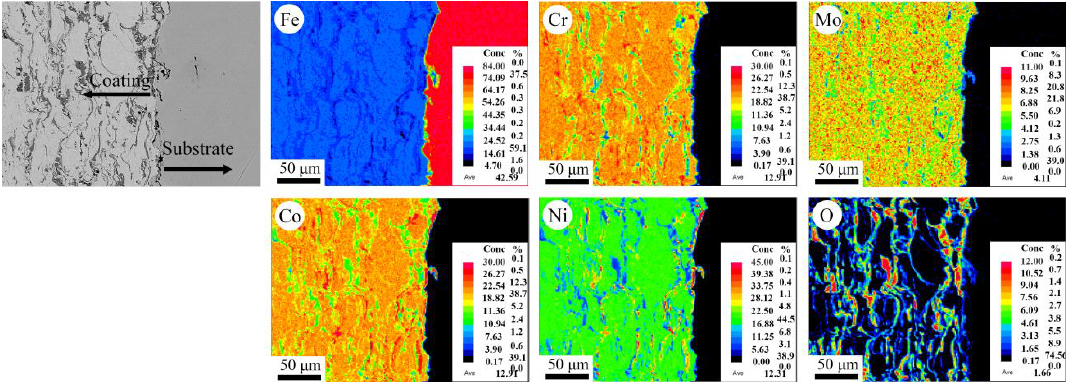
Figure 4. The elemental mapping with electron probe microanalysis (EPMA) in the APS coating.